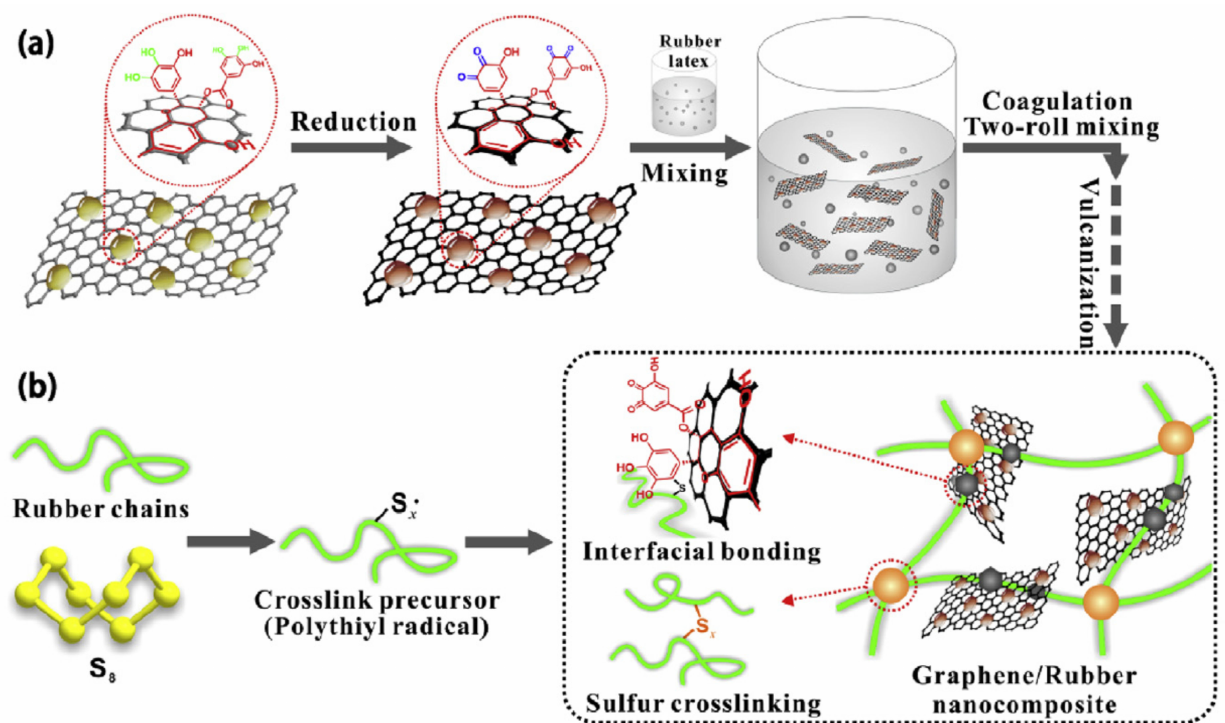
Figure 33. Schematic representations of the fabrication process of graphene/rubber nanocom- posites and the formation mechanism of covalent interface between graphene and rubber matrix: ( a ) fabrication of graphene/rubber nanocomposites and ( b ) formation mechanism of covalent inter- face between graphene and rubber matrix